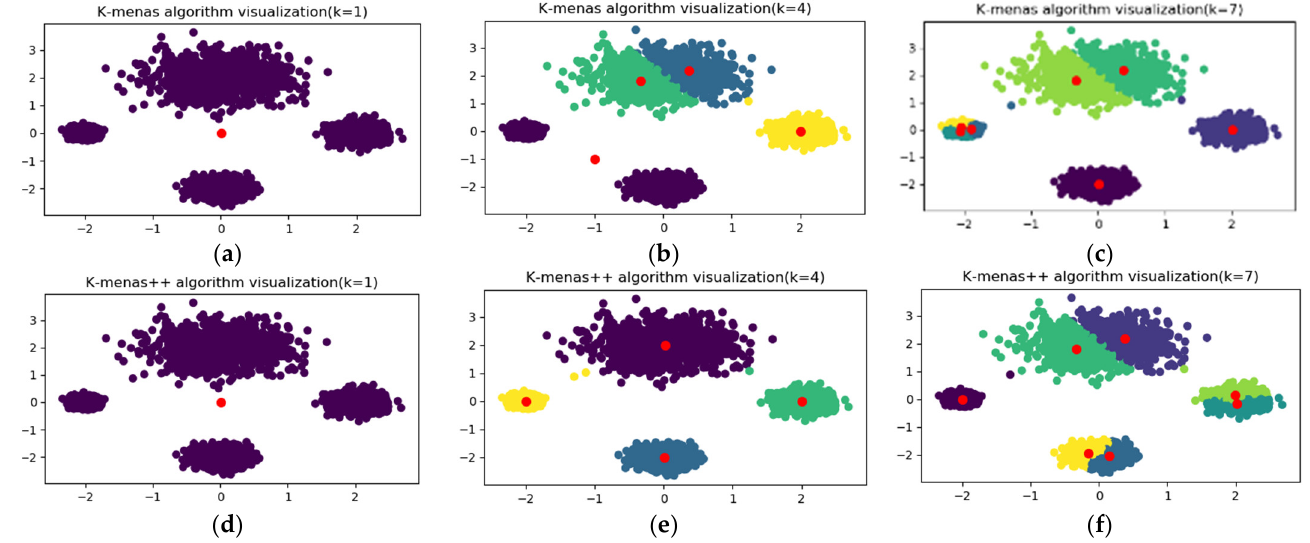
Figure 5. Comparison between K-means and K-means++ algorithms. ( a ) One cluster centers (K-means). ( b ) Four cluster centers (K-means). ( c ) Seven cluster centers (K-means). ( d ) One cluster centers (K-means++). ( e ) Four cluster centers (K-means++). ( f ) Seven cluster centers (K-means++).